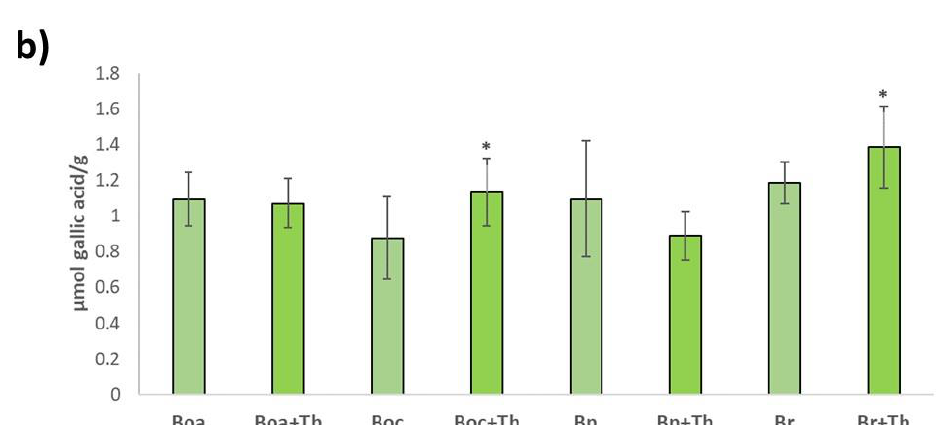
Figure 3. Antioxidant activity (ABTS + ) ( a ) and phenolic content (Folin reagent) ( b ) in leaves from kale (Boa), cabbage (Boc), leafy rape (Bn) and leafy turnip (Br) without inoculation and inoculated with T. hamatum (+Th). Data are the mean of 10 plants for each crop and condition with the corresponding standard deviation. Student’s t -test was performed. Asterisks denote significant differences at p ≤ 0.05 (*).